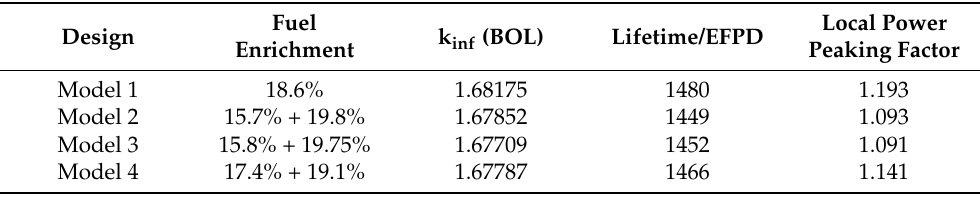
Table 7. Calculation results of different power-flattening designs.